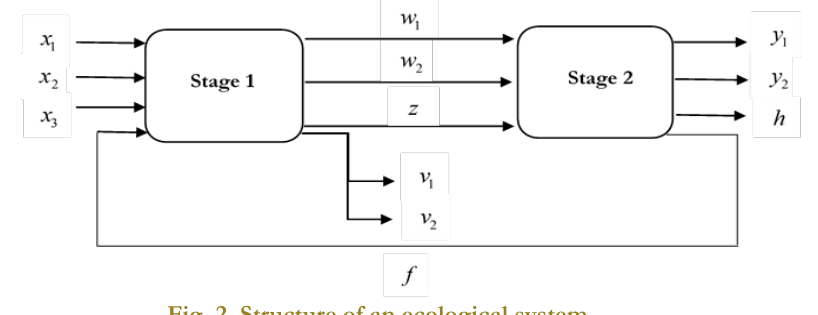
Fig. 2. Structure of an ecological